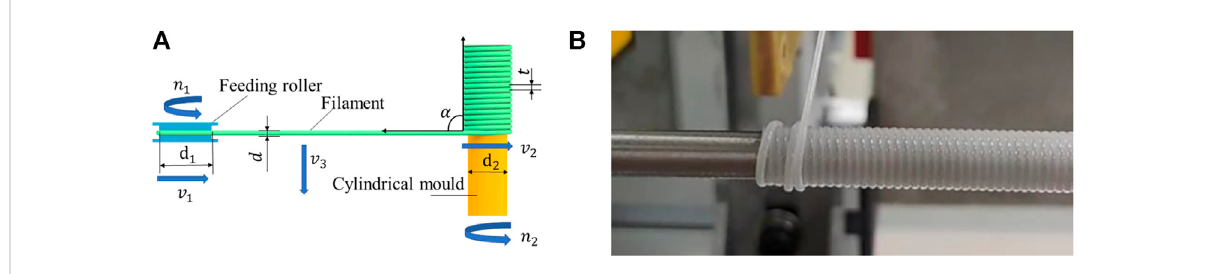
FIGURE 12 Winding diagram and winding diagram. (A) Winding Diagram (Top View). (B) Reverse Winding